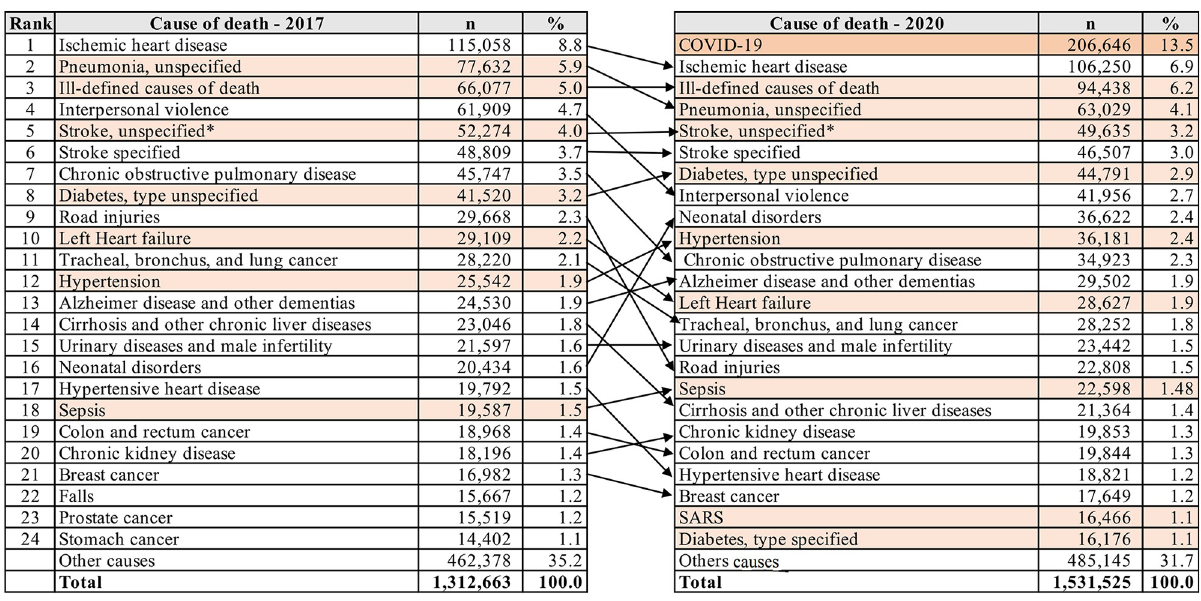
Fig 1. Leading causes of death in 2017 and 2020 in Brazil, with garbage codes highlighted. � code ICD-10 I67.8 not included; �� SARS in 2017: 3450 deaths (0.26% of total deaths) Source: Mortality Information System (SIM)- Accessed on April 23, 2021 (raw data).